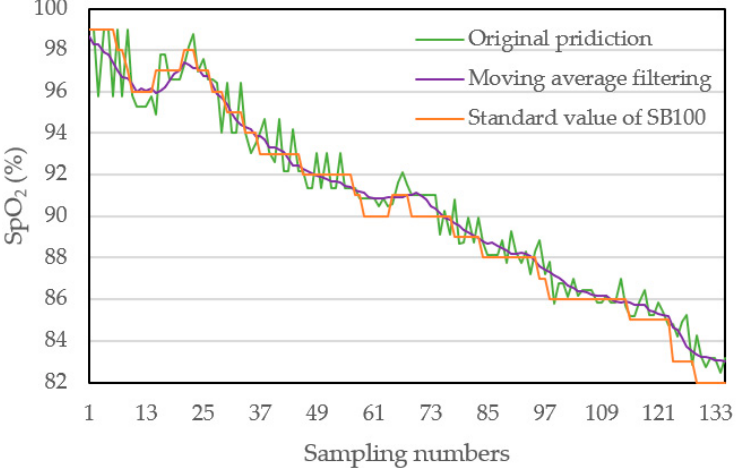
Figure 13. Original spectral data and measurement results after moving average